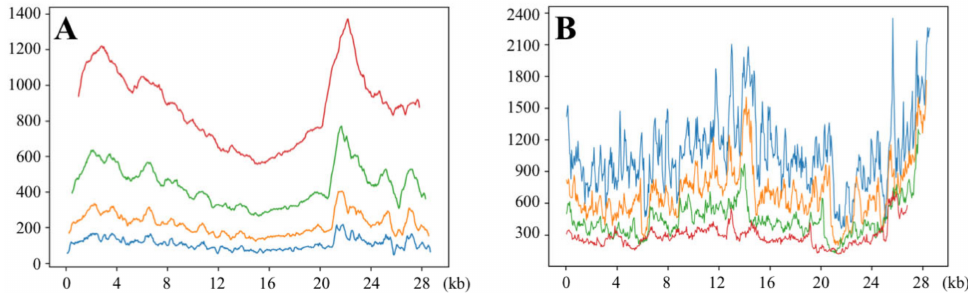
Figure 2. Number of informative sites ( A ) and bipartitions ( B ) found in the SWB analyses based on four window sizes. The alignment of 56 Sarbecovirus genomes was analyzed using four sliding window sizes: 250 nt (blue), 500 nt (orange), 1000 nt (green), and 2000 nt (red). The scale in abscissa shows the positions in the